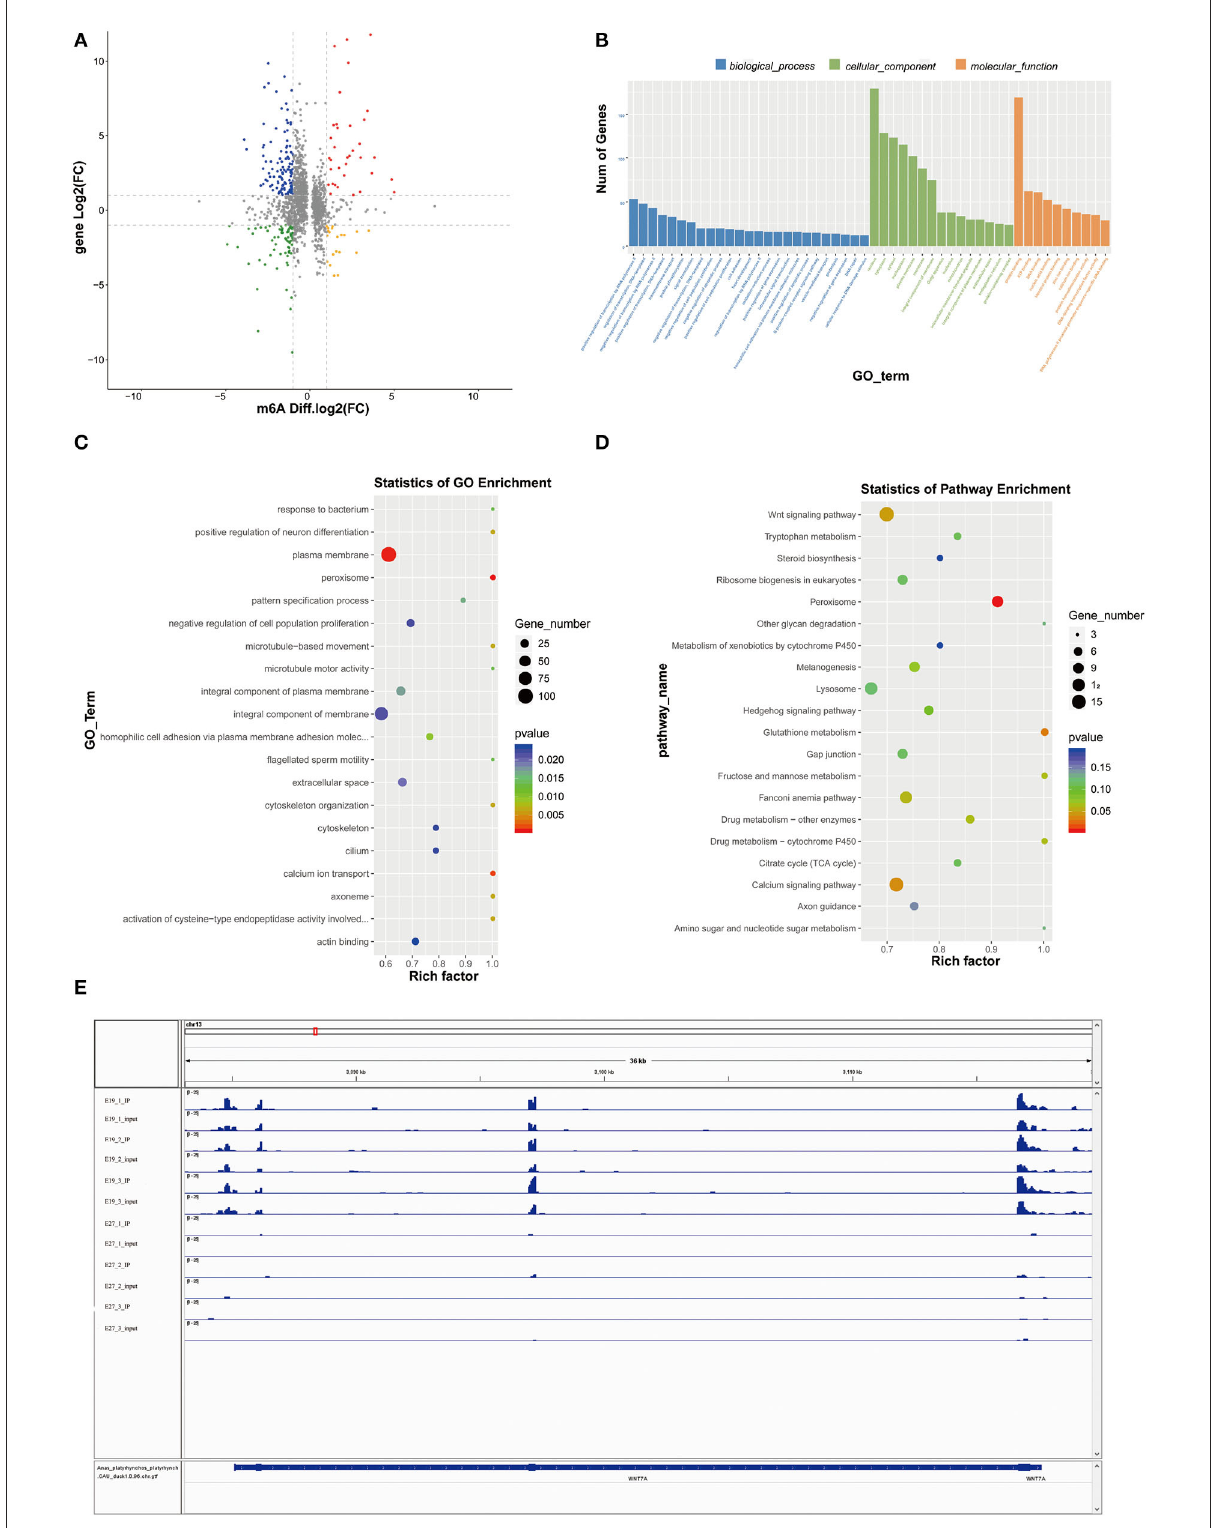
FIGURE5 Conjoint analysis of m6A-seq and RNA-seq data. (A) Distribution of genes with a significant change in both m6A methylation level and gene expression between E19 and E27. Up–up, up–down represent genes with increased m6A methylation level and increased